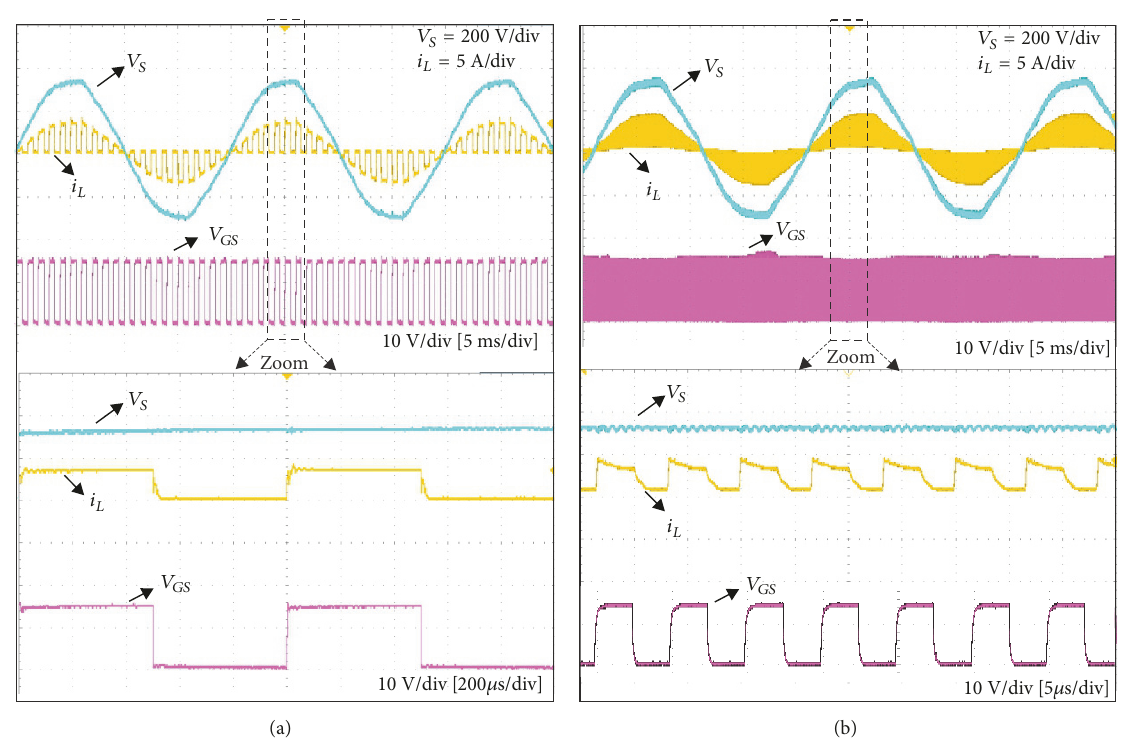
Figure 9: Waveforms of the ac voltage regulator. 𝑉 𝑆 = 220 V 50Hz power supply, 𝑖 𝐿 output current, and 𝑉 𝐺𝑆 gate voltage at (a) 𝐹 𝑆𝑊 = 1 kHz, 50% duty cycle and (b) 𝐹 𝑆𝑊 = 100kHz, 50% duty